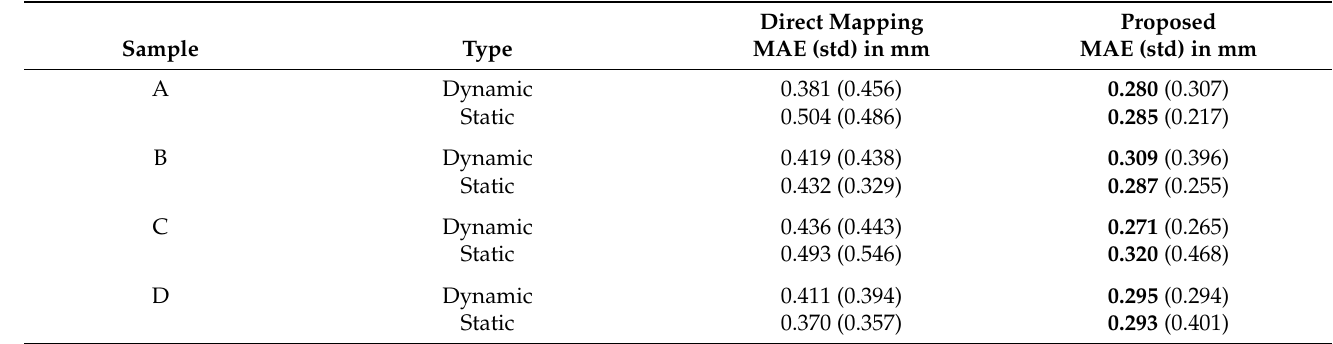
Figure 17. Comparison of 3D reconstruction for sample C acquired during movement using Estrada’s unwrapping algorithm with the ( a ) direct mapping and the ( b ) proposed virtual reference methods. Blue areas correspond to lower error than green ones. The border artefacts of the Fourier transform are visible as high-error areas (yellow and red). Table 6. Compared MAE (and standard deviation) of the direct mapping versus the proposed virtual reference method with Estrada’s unwrapping algorithm ( τ = 0.8) over both static and dynamic